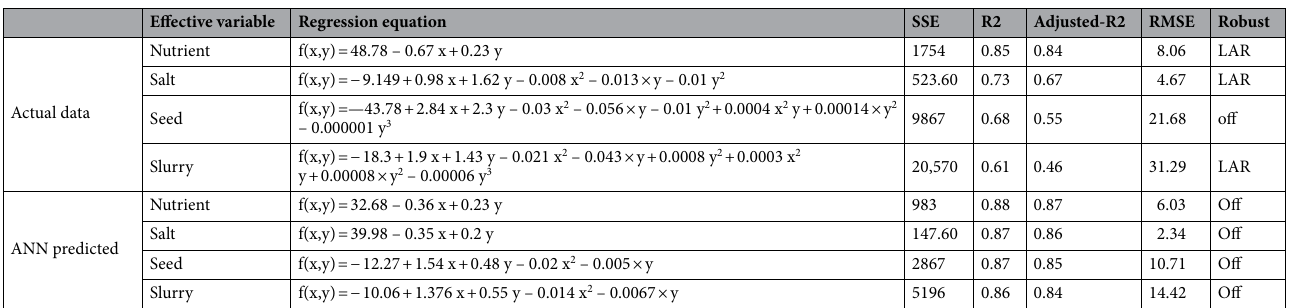
Table 6. The fitting of effective variables on removal of hexane during the variation of initial hexane concentration and time exposure of consortium culture. x = hexan, y =